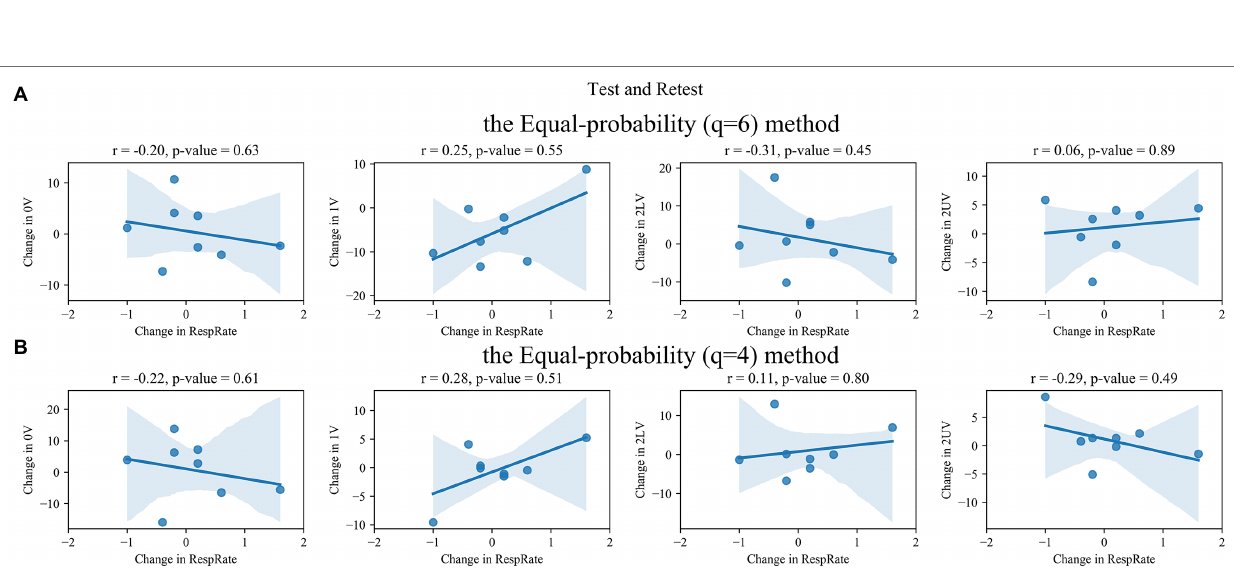
FIGURE 7 | Correlation between retest–test differences in SymDyn indices and differences in respiratory rate (RespRate): the Equal-probability method (A) q = 6, (B) q =